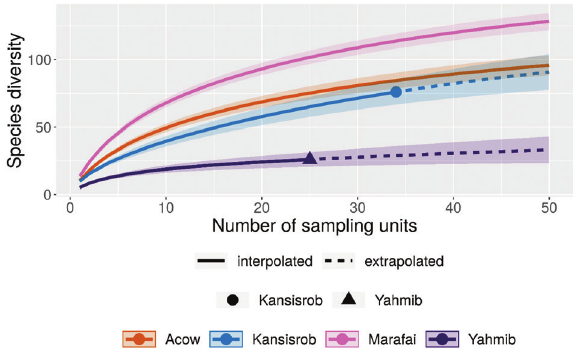
Figure 7. Sample-size-based rarefaction and extrapola- tion sampling curve for the four studied wadis.